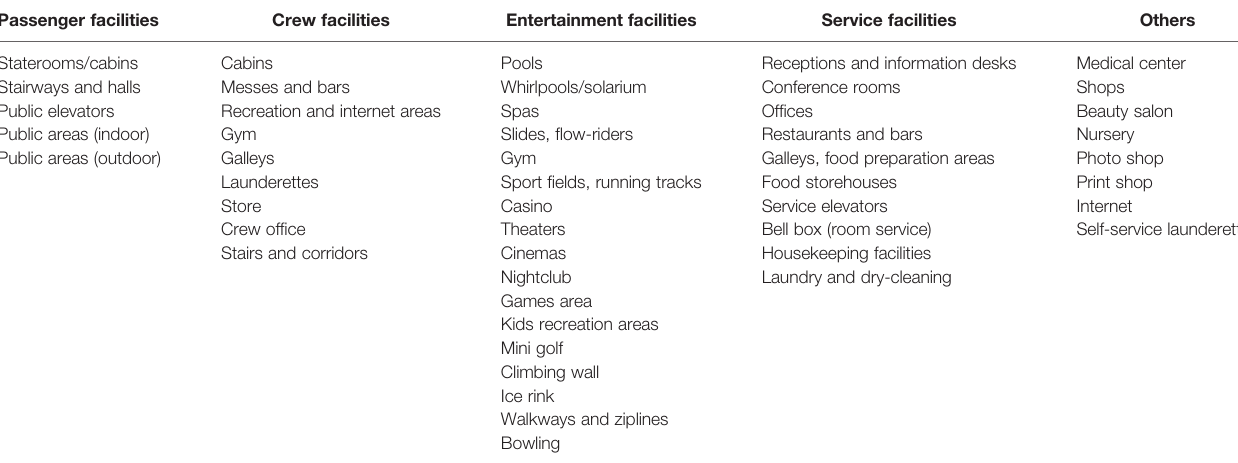
TABLE 3 | Hotel facilities on board cruise ships [adapted from Lois et al. (2004)].